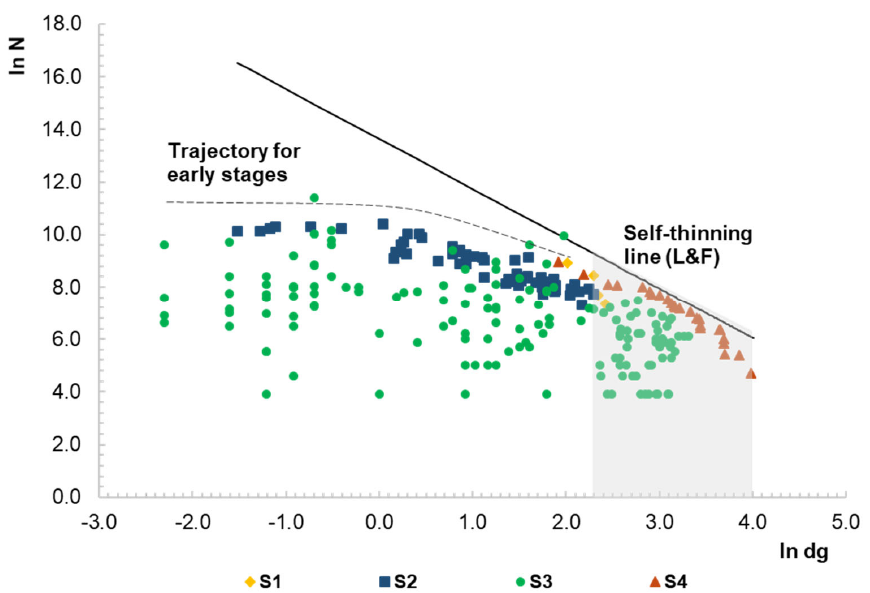
Figure 2. Diagram of dispersion and relationship between the logarithm of N (trees.ha − 1 ) and the logarithm of quadratic mean diameter ( dg (cm)), for the observations of the four data subsets. Two lines are imposed: the estimated maximum size–density values according to the allometric model by Luis and Fonseca [28] (L & F), and a hypothesized line (hand-drawn, dashed) placed close to the extreme pairs of ( dg, N ) values registered for the young stands. The shaded area represents the domain region of the L&F model, for the diameter variable.